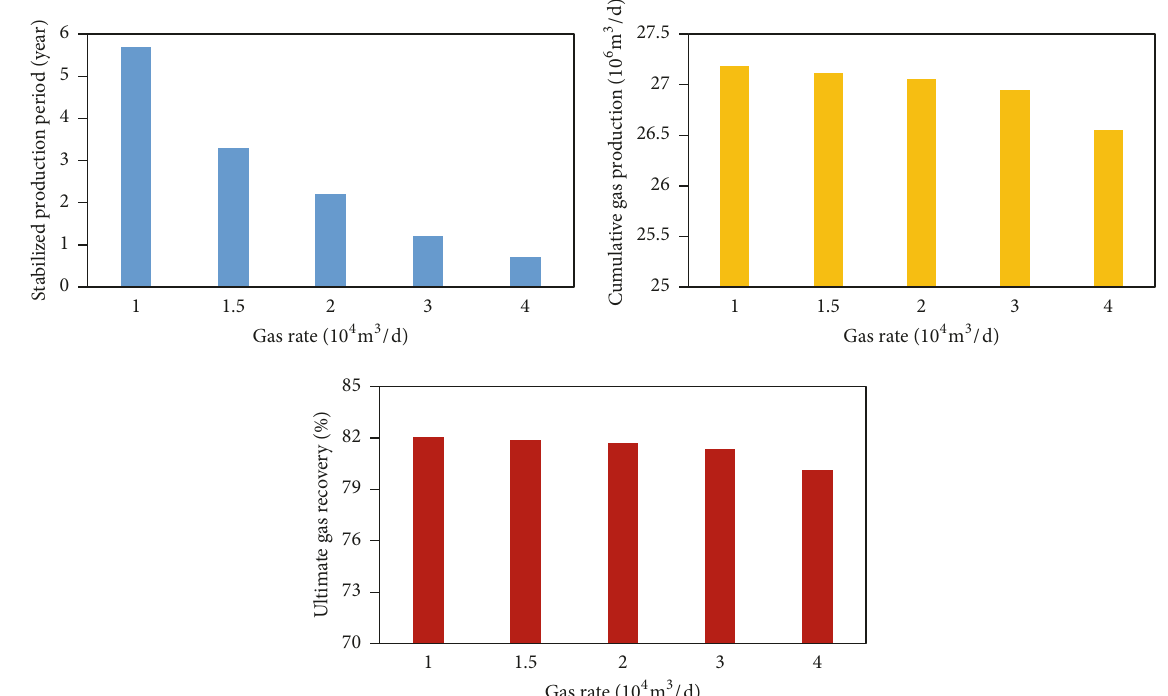
Figure 21: The stabilized production period, cumulative gas production, and gas recovery under different gas rates.